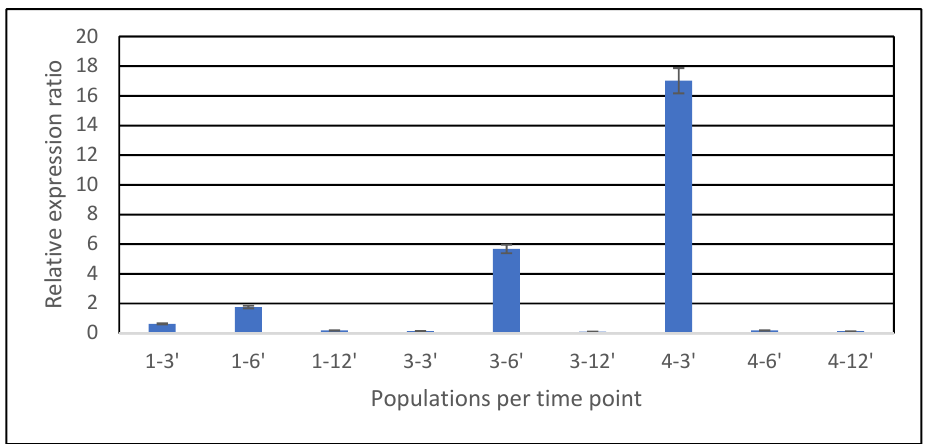
Figure 5. Relative expression ratio of the Lpmultidrugprotein gene for the populations 1, 3 and 4 in glyphosate-applied leaves (3, 6 and 12 h after glyphosate application). Similarly, for the Lpironinhibited ABC transporter gene, population 4 responded 3 h after glyphosate application (eight-fold up-regulation), while population 3 showed a three-fold up regulation at 12 h after treatment. A two-fold up regulation was also observed for population 1 at 6 h after glyphosate application (Figure 6).